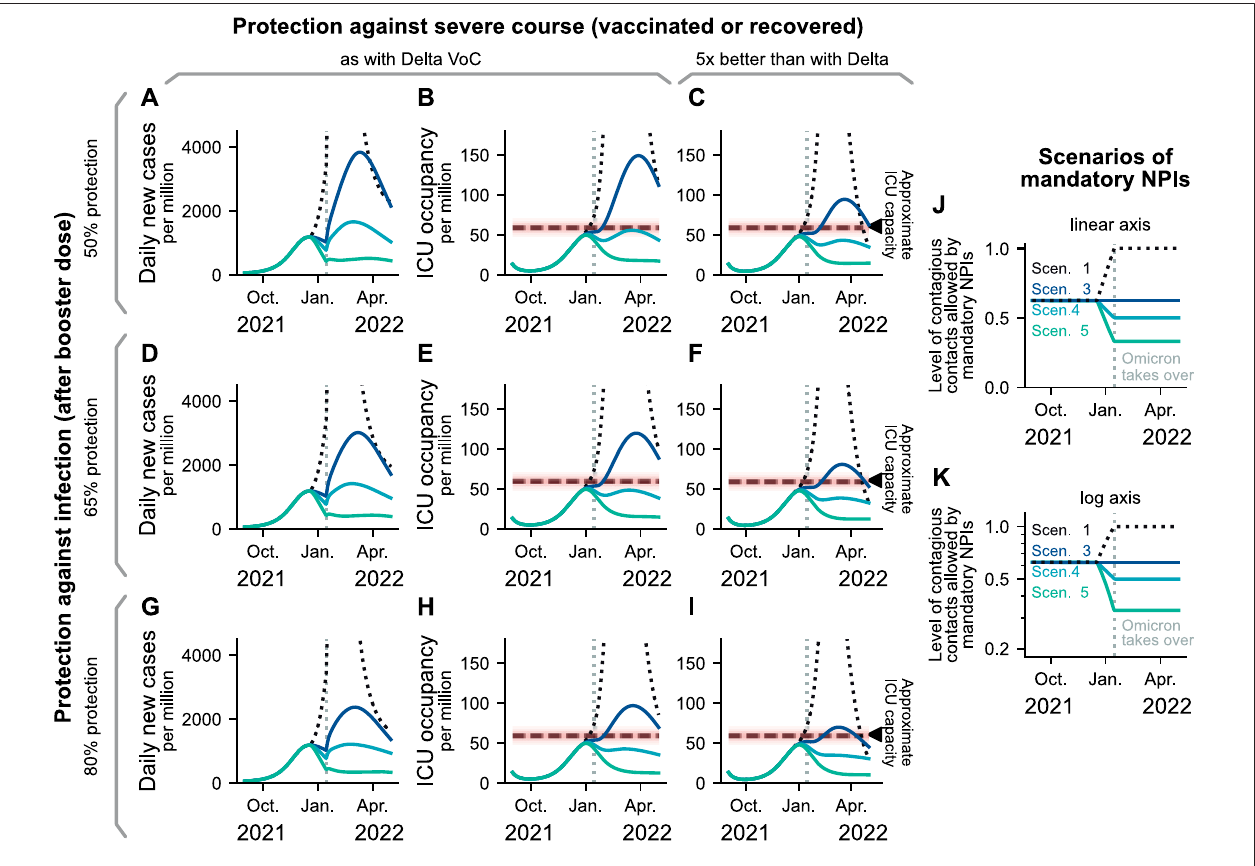
FIGURE6| DevelopmentofthepandemicundertheemergenceoftheOmicronVOC.AssumingafullreplacementofDeltabytheOmicronVOCon15thofJanuary 2022, we model three different possibilities for vaccine-protection against infection, and two levels of long-lasting vaccine- or post-infection protection against severe course (A – I) . In color, we display four scenarios that are derived from the previously studied ones (J,K) . All scenarios share moderate mandatory NPIs until mid December 2021,where weevaluate differentpossibilitiesfor policyadaptationtomitigatethe spread oftheOmicronVOC. (A,B,D,E,G,H) :Case numbers and ICU occupancy while assuming that a protection againsthospitalization (once infected despite previous immunization) is similar to the protection against Delta. (C, D, I) : ICU occupancy while assuming a protection against hospitalization (once infected and after previous immunization) fi ve times better than the protection regarding Delta.